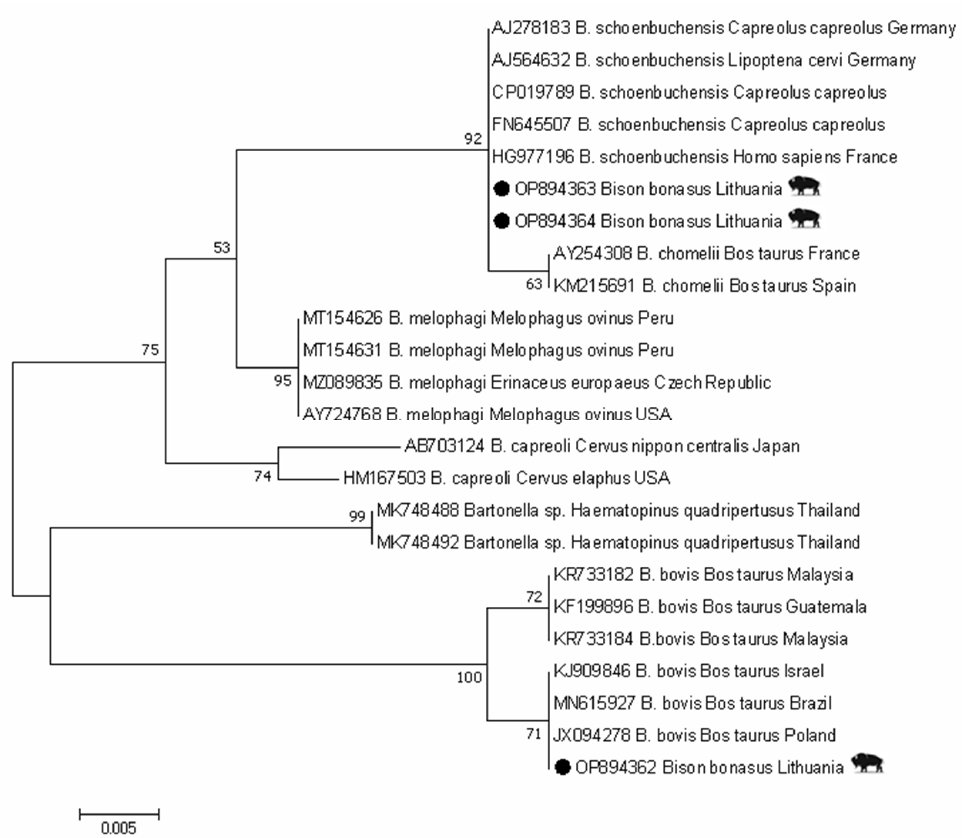
Figure 2. Phylogenetic tree of Bartonella spp. using gltA gene sequences constructed by Maximum Likelihood method and Tamura–3 parameter model. Numbers on the tree indicate bootstrap support (values < 50% not shown). The identification source (host) and country are given after the accession numbers. Bartonella sample in this study isolated from European bison is marked with ● .